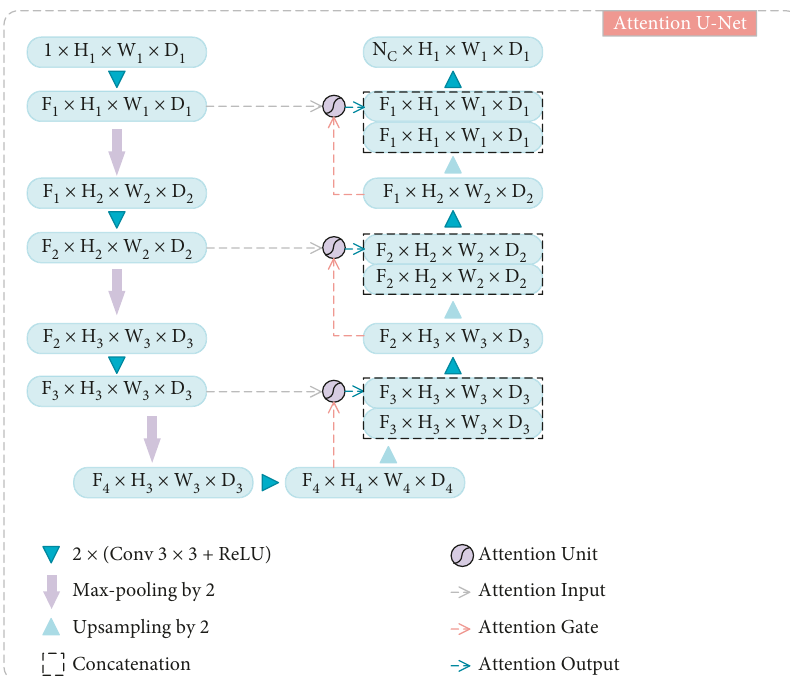
Figure 6: Structure of